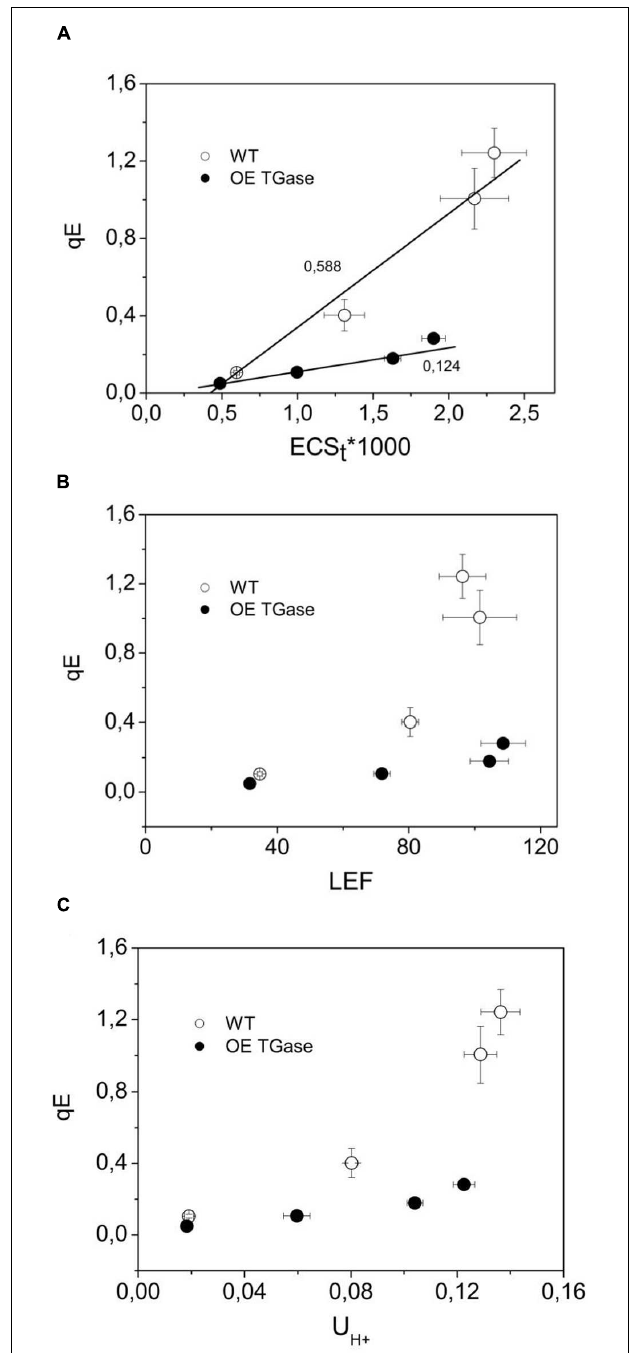
FIGURE 5 | The regulation of PSII antenna. (A) The downregulation of the antenna in relation to the amplitude of pmf . (B) The downregulation of the antenna in relation to the amplitude of LEF. (C) The downregulation of the antenna in relation to proton efflux from lumen to stroma. The lower sensitivity of antenna downregulation (qE) to light induced proton motive force (ECSt) indicates that there is probably a higher buffering capacity and a higher (cid:49) ψ /pmf in OE TGase thylakoids of intact leaves. By recording in vivo the decay of the ECS at three wavelengths and deconcoluting other processes we provide estimates of the higher (cid:49) ψ /pmf in OE TGase (please see Table 1 ). Error bars denote standard error ( n = 6).